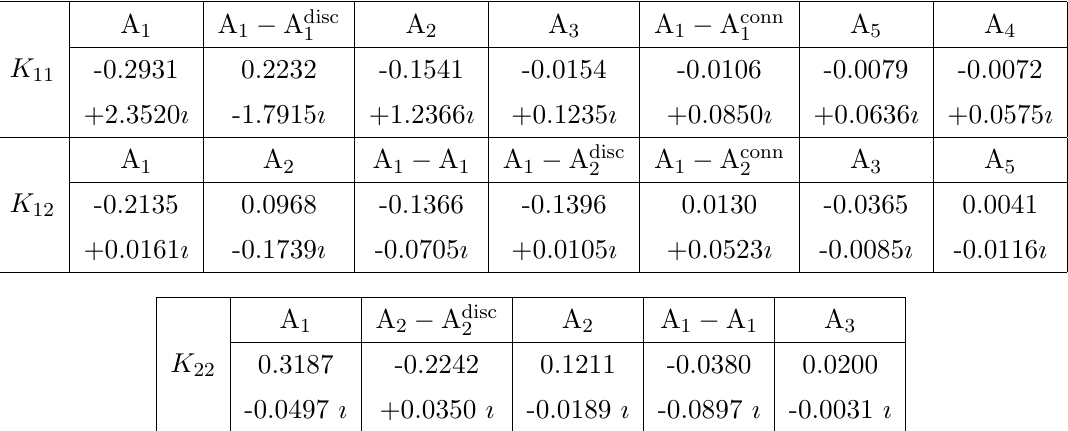
Table 2 . Most sizeable contributions in second order to K ab ( # ) at # = 0 : 45. Upper row for each particle indicates the inserted state. The superscript \disc", where present, indicates whether it is the disconnected or the connected part of the diagonal form